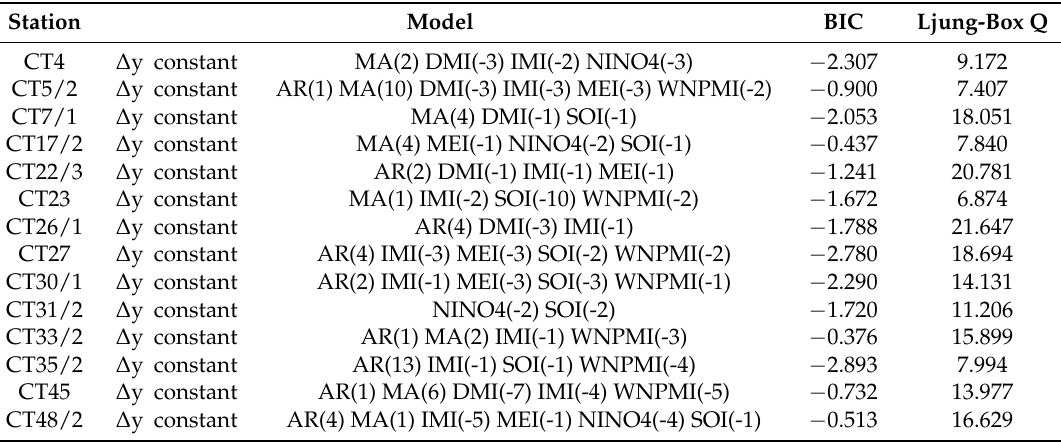
Table 9. ARIMAX model of each